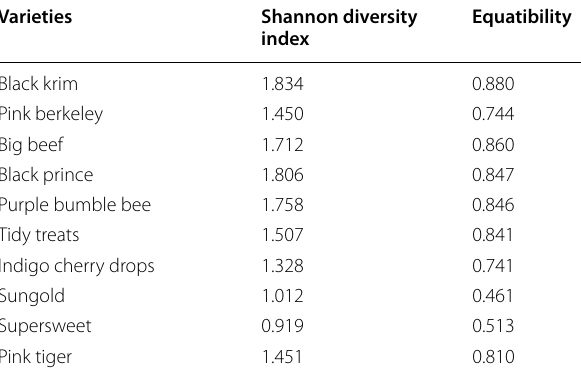
Table 3 The results of Shannon Weiner diversity index and equitability for trichomes in tomato varieties